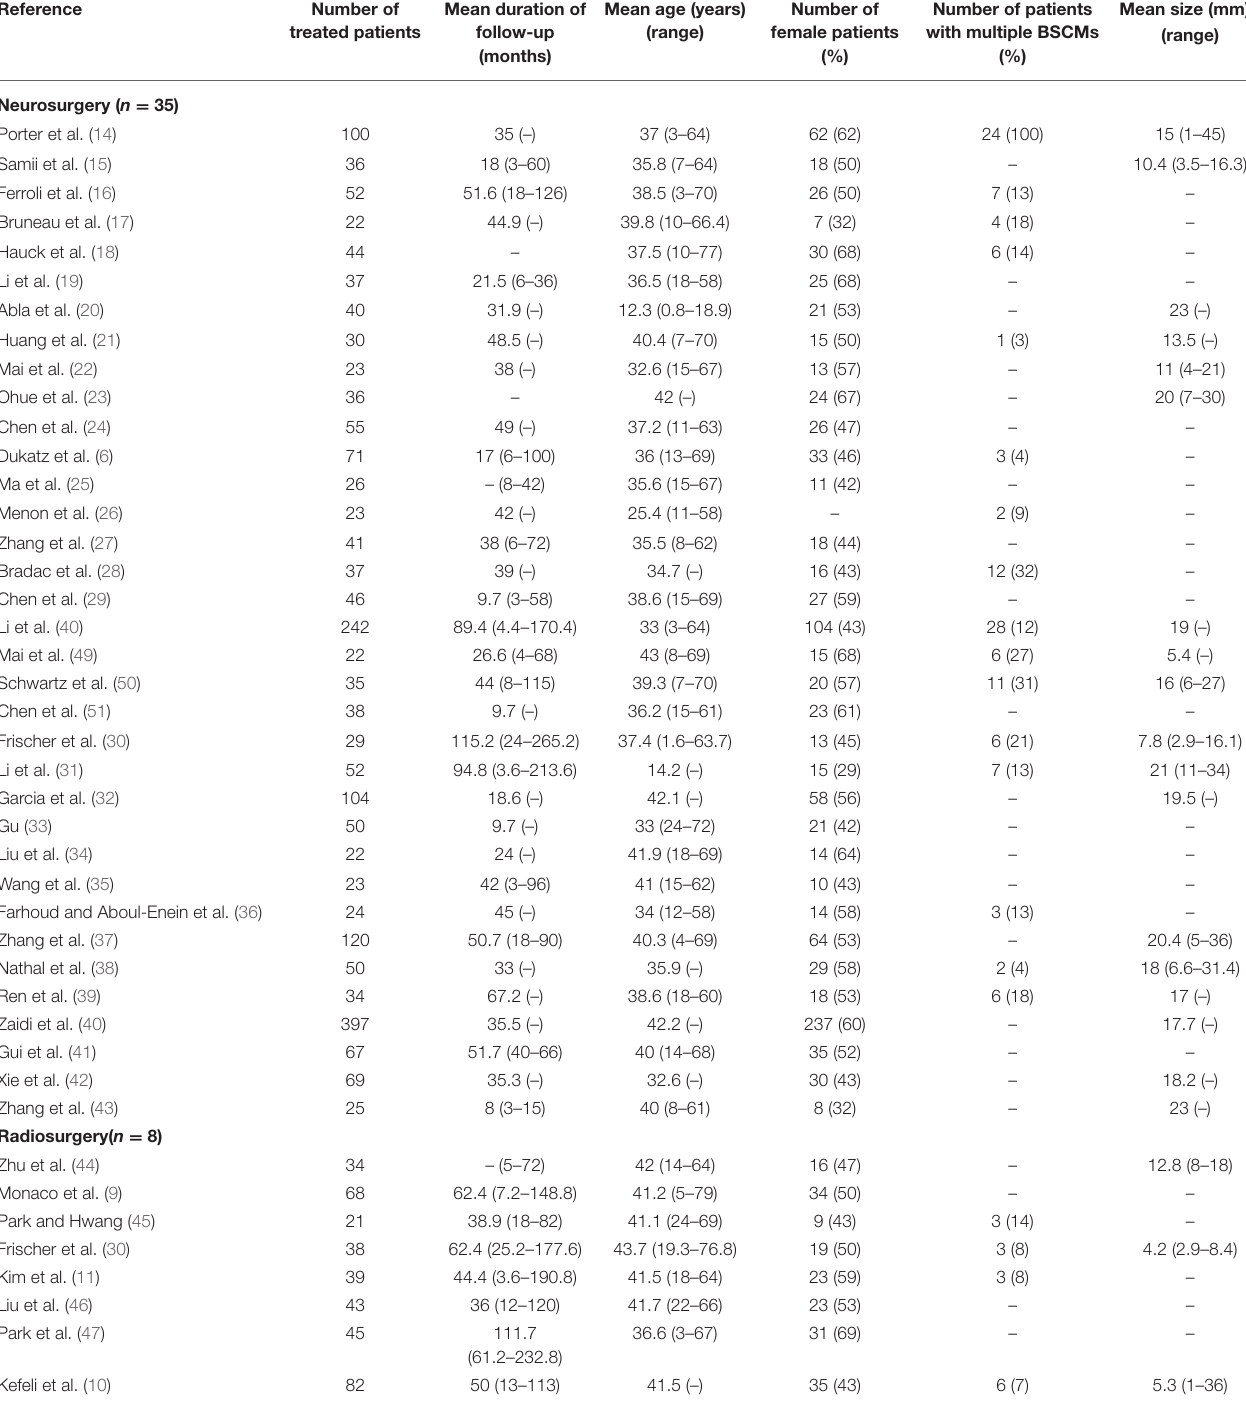
TABLE 1 | Basic patient characteristics of each included